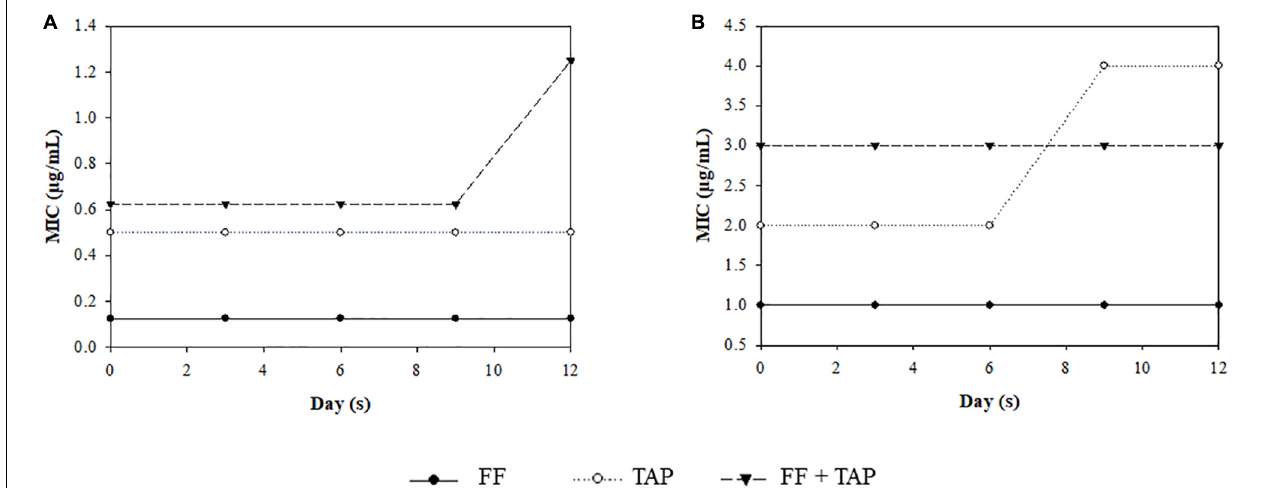
FIGURE 5 | Gross lesions and histopathology of the pig lungs (A) Gross lesions of the pig lungs (dorsal and ventral side) in groups 1–5: Group 1 showed firm and dark red of the apical, cardiac parts of left cranial lobe and right cranial lobes (arrows) and 4 × 4 cm hematoma on dorsal surface of left diaphragmatic lobe (asterisks); Groups 2–5 showed few gross pathological signs. (B) Histopathology of the lung tissues (the right cranial lobe): Group 1 showed signs of interstitial pneumonia; The lung tissues from pigs in groups 2–5 showed only minor pathological changes (HE stain, 40 × ).